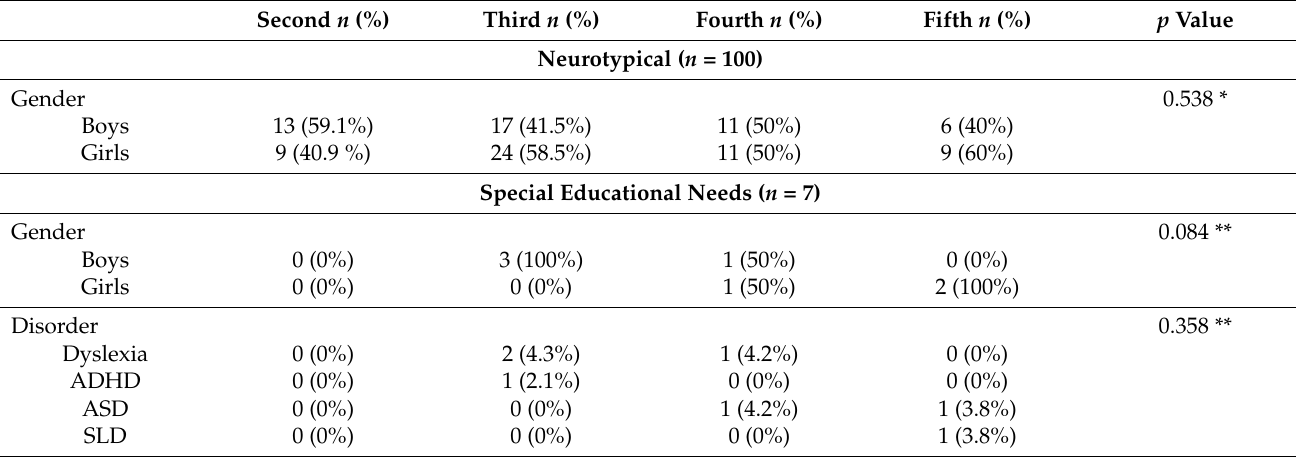
Table 1. Characteristics of children by primary school level ( n =